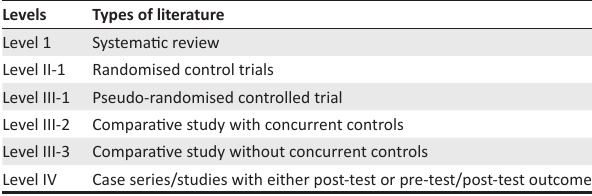
FIGURE 1: Conceptualisation of the review process. TABLE 1: Hierarchy of